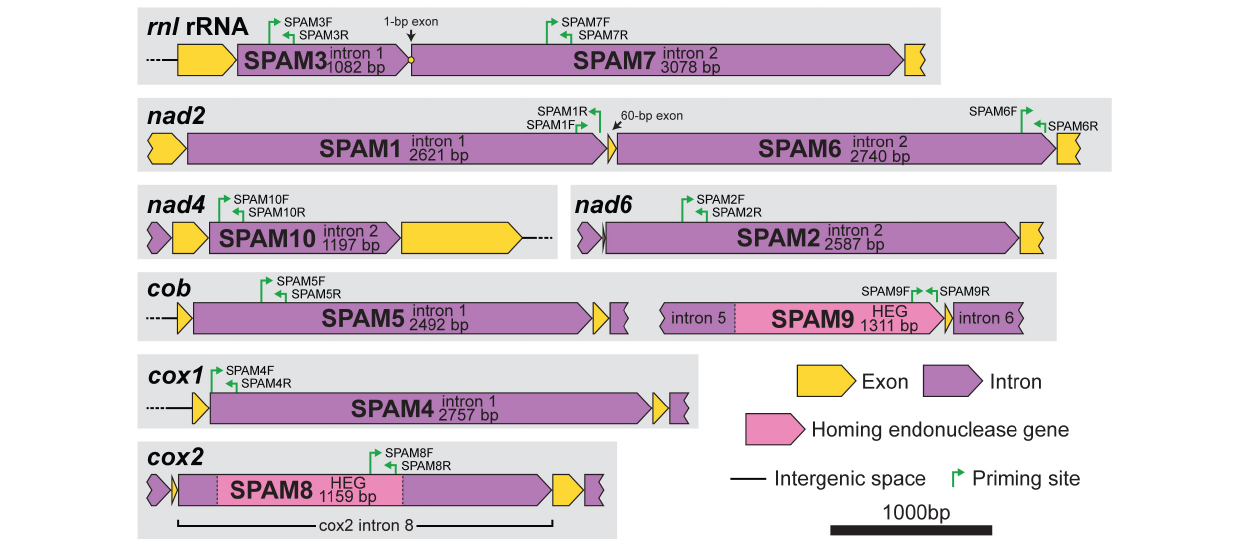
Frontiers in Microbiology |